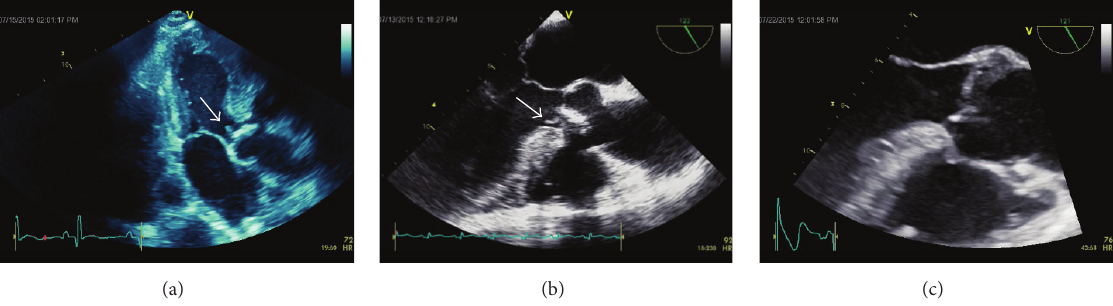
Figure 1: (a) Transthoracic echocardiogram image demonstrating a vegetation (arrow) on the ventricular surface of the aortic valve. (b) Transesophageal echocardiogram image demonstrating the small vegetation on the ventricular surface of the aortic valve, as well as aortic valve thickening in patient with known bicuspid aortic valve. (c) Follow-up transesophageal echocardiogram demonstrating no evidence of previously visualized vegetation, suggesting its resolution or embolism. No evidence of pseudoaneurysm was detected on serial echocardiographic studies.